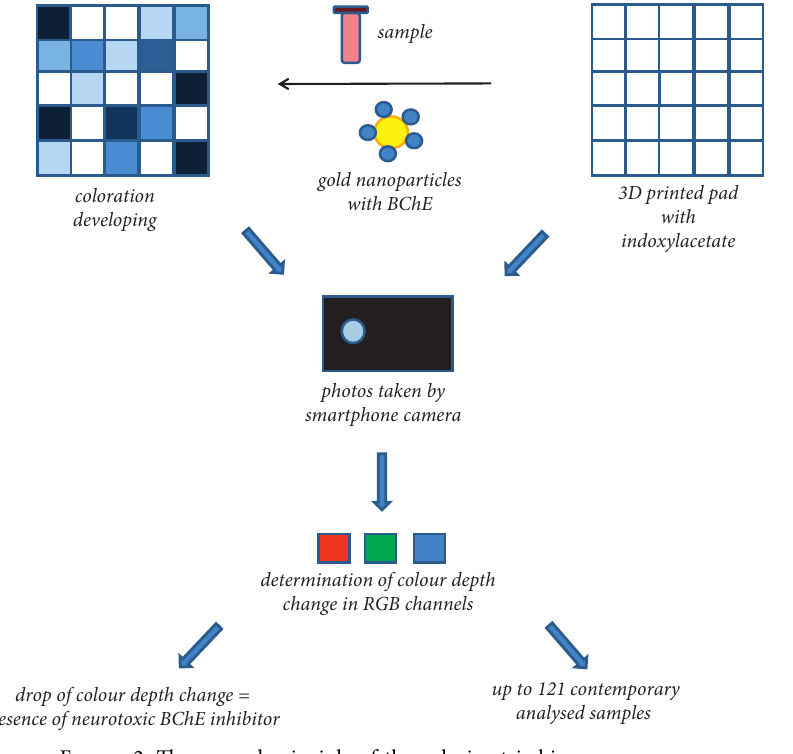
Figure 2: The general principle of the colorimetric biosensor assay.